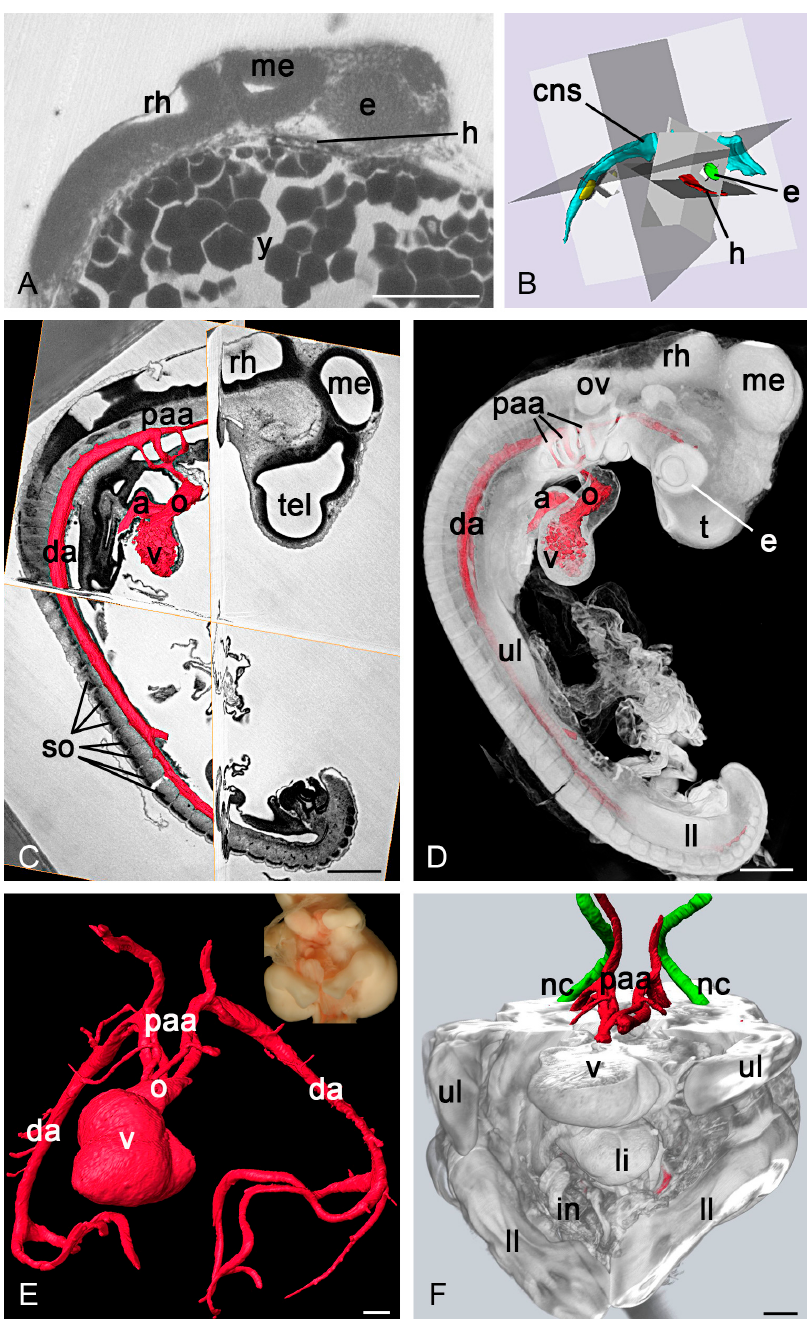
Figure 3. HREM for analysing the cardiovascular system of biomedical models. ( A ) Sagittal section through the head of a zebrafish embryo, 48 h after conception. ( B ) Surface models of the cranial parts of the central nerve system (cns), eye (e) and heart (h) with mathematically calculated and displayed planes through their main axes. ( C , D ) Surface models of the heart and arteries (red) of a chick embryo of stage 18 according to Hamburger Hamilton (HH) together with virtual resections through HREM data ( C ) and in the context of a semitransparent volume model of the embryo surface ( D ) respectively. ( E , F ) HH 34 chick embryo with cephalothoracopagus malformation. Surface models show a single heart and pharyngeal arch artery system (red) feeding the descending aorta of each twin ( E ). Additional surface models of the notochords (nc, green) in an opaque volume model of the surface with virtually excluded cranial parts from anterior ( F ). a, atrium; da, dorsal aorta; e, eye; in, intestine; li, liver; ll, lower limb; me, mesencephalon; nc, notochord; o, outflow tract; ov, otic vesicle; paa, pharyngeal arch arteries; rh, rhombencephalon; so, somite; t, telencephalon; ul, upper limb; v, ventricle. Scalebars: 100 µm ( A ), 500 µm ( C – F ).